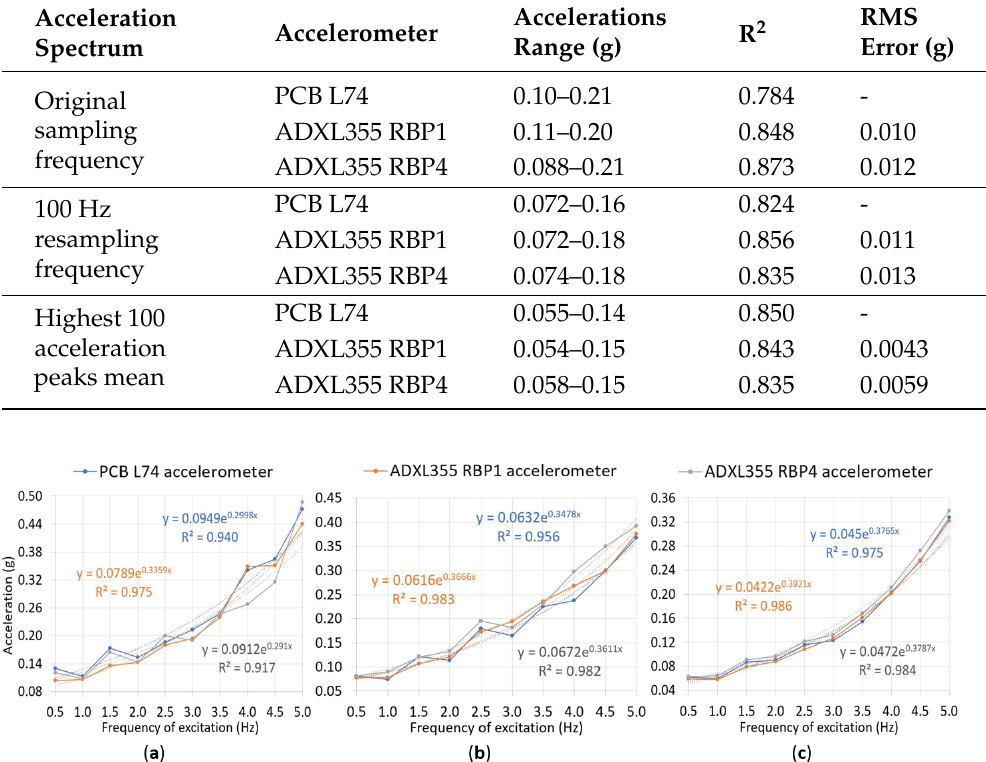
Figure 11. Acceleration spectra for the 0.10 cm displacement frequency chirp: ( a ) Maximum accelera- tion spectrum from original sampling frequency. ( b ) Maximum acceleration spectrum from 100 Hz resampling frequency. ( c ) Acceleration spectrum for the mean of the highest 100 acceleration peaks from 100 Hz resampling frequency. Table 3. Summary of the results obtained from the 0.10 cm displacement frequency chirp.